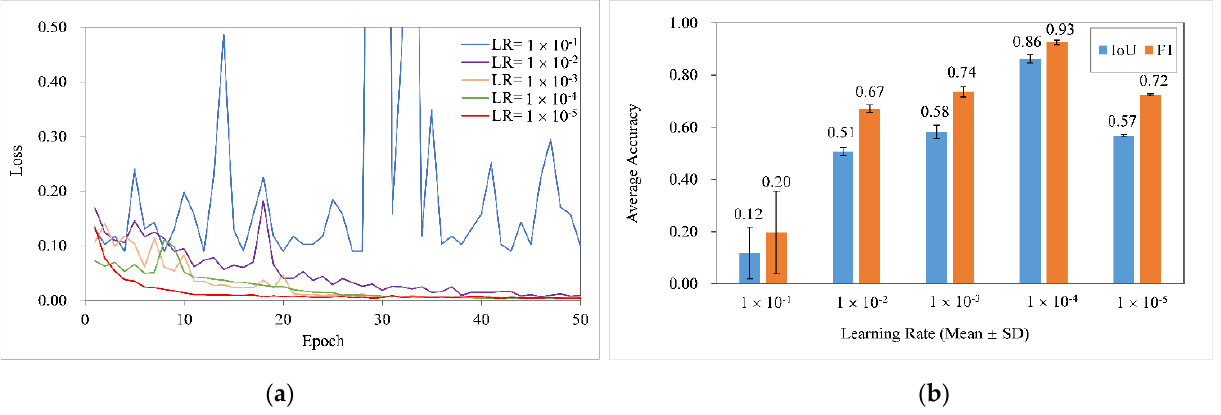
Figure 5. ( a ) Different learning rates on the validation set in 50 epochs; ( b ) average accuracy and standard deviation under different learning rates.